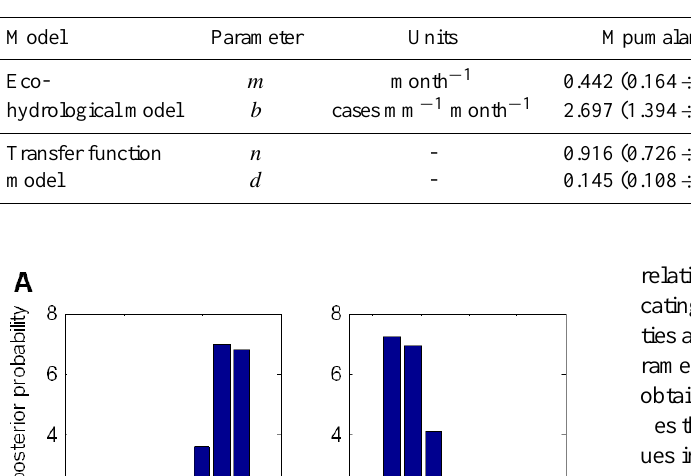
Table 2. Best set of model parameters (and 95% confidence level) of the ecohydrological and transfer function models for the three provinces illustrated in Fig. 1.